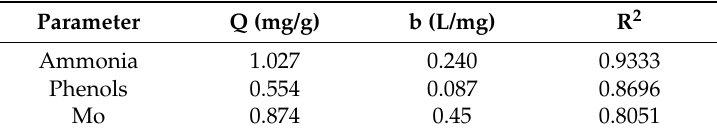
Table 5. Langmuir equation for ammonia, phenols, and